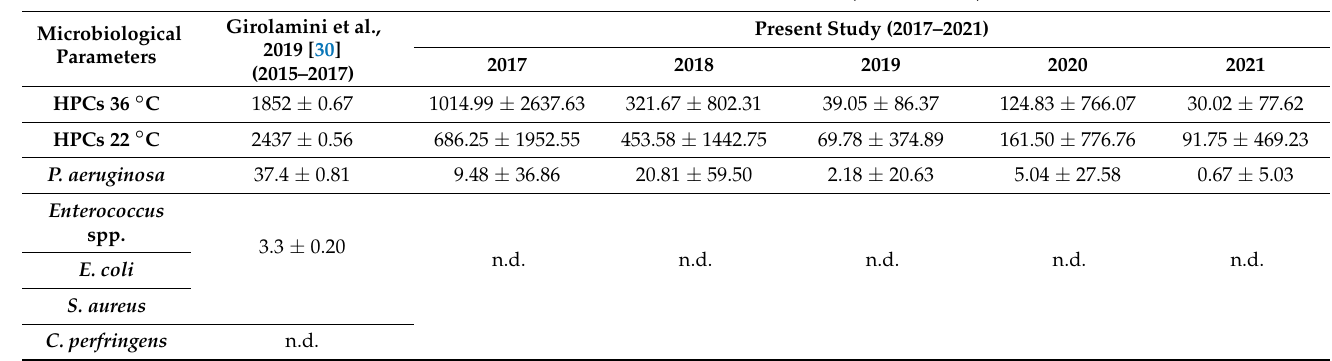
Table 1. MWDs’ mean contamination ± standard deviation (cfu/mL ± SD) found at the beginning of the WSP implemented in 2017 until today (2021), with respect to mean contamination found in the previous study (Girolamini et al., 2019), from 2015 to 2017.